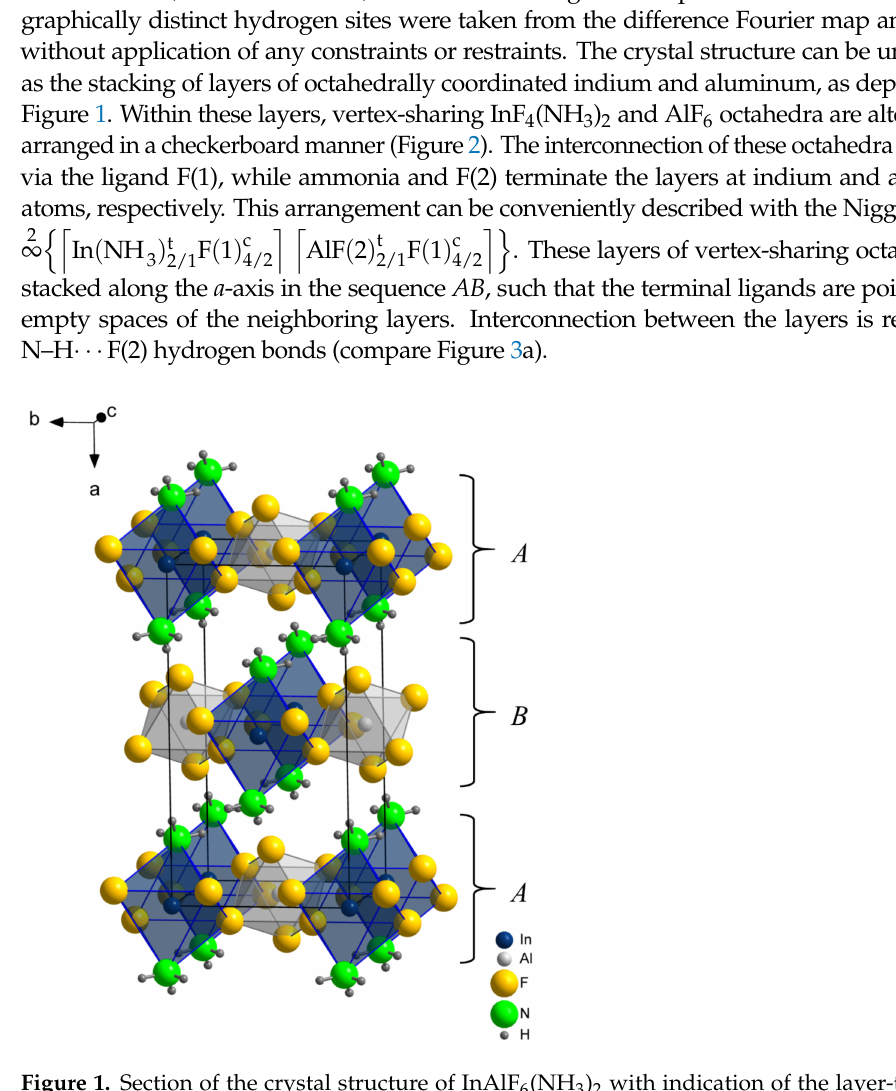
Figure 1. Section of the crystal structure of InAlF 6 (NH 3 ) 2 with indication of the layer-type motif. The unit cell is